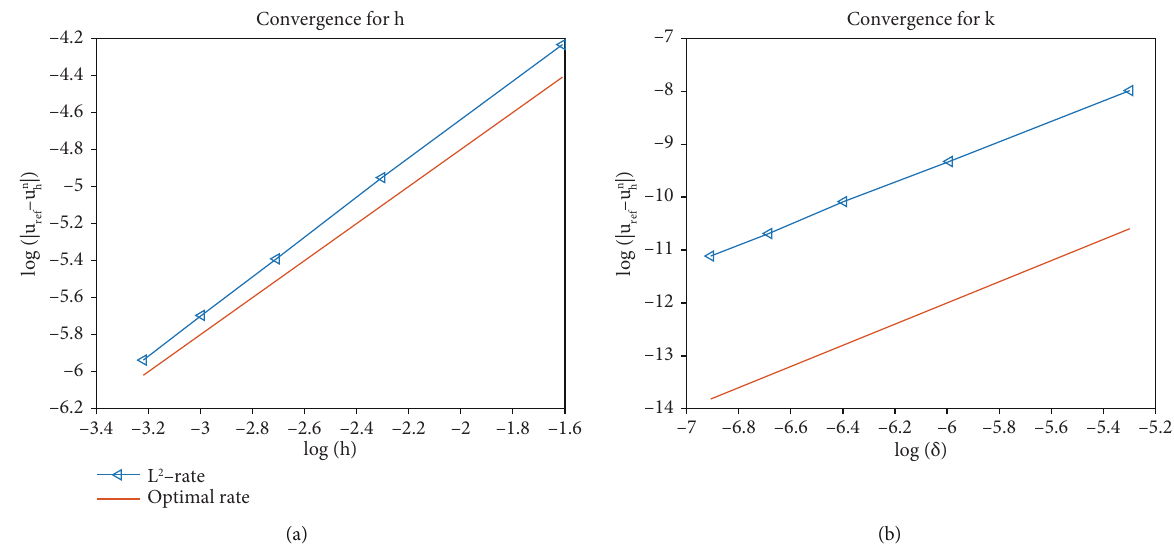
Figure 2: L 2 -error estimate, respectively, for mesh size h and time step k